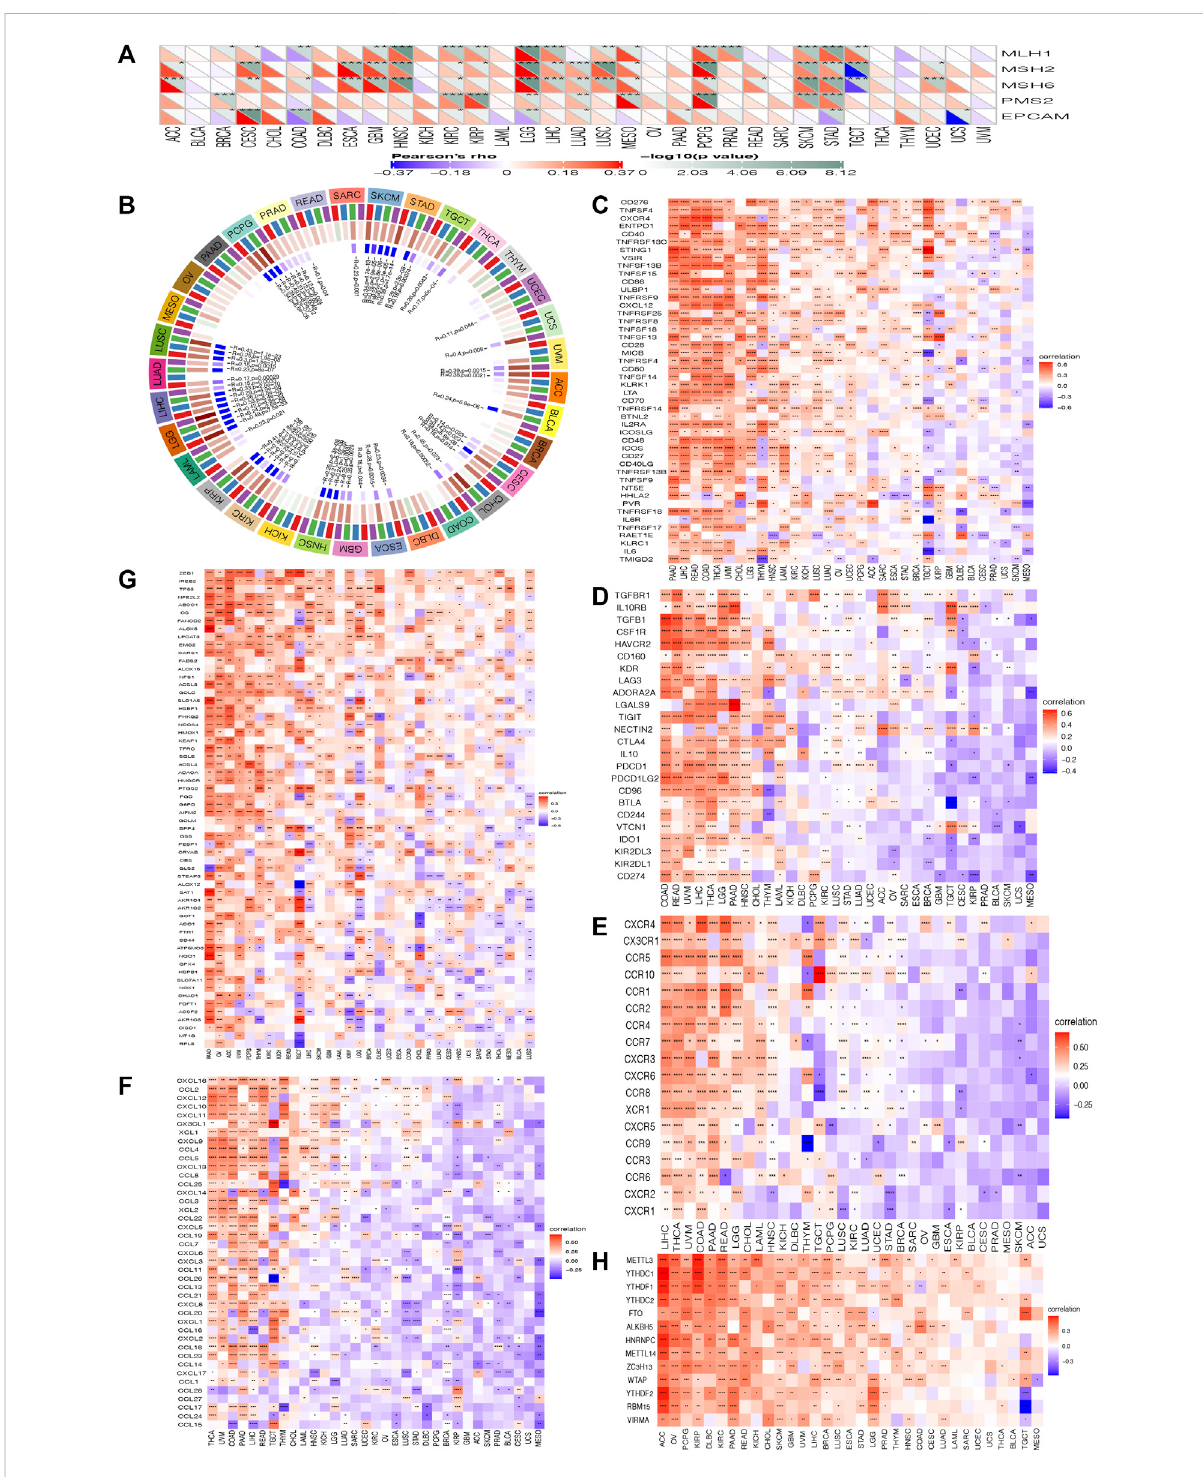
FIGURE 5 Correlation analysis between the expression of HOXC4 and (A) MMR mutation genes (B) DNA methyltransferases (C) immune activation (D) immunosuppressive (E) chemokine receptor gene (F) chemokine (G) ferroptosis (H) m6A; *** p < 0.001, ** p < 0.01, * p < 0.05, no * p >